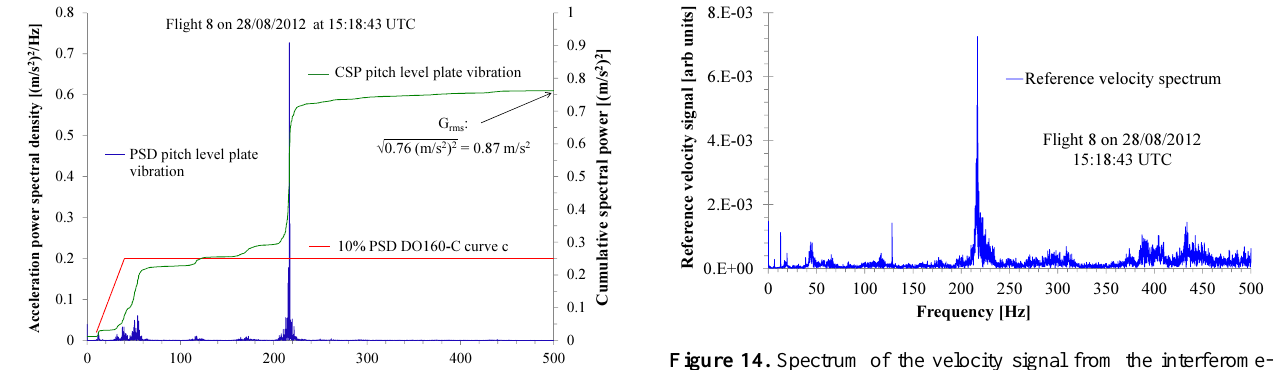
Figure 14. Spectrum of the velocity signal from the interferome- ter measured with the reference laser during the same time period which is illustrated in Fig. 13. The largest peak is caused by the strongest vibration identified in Fig.